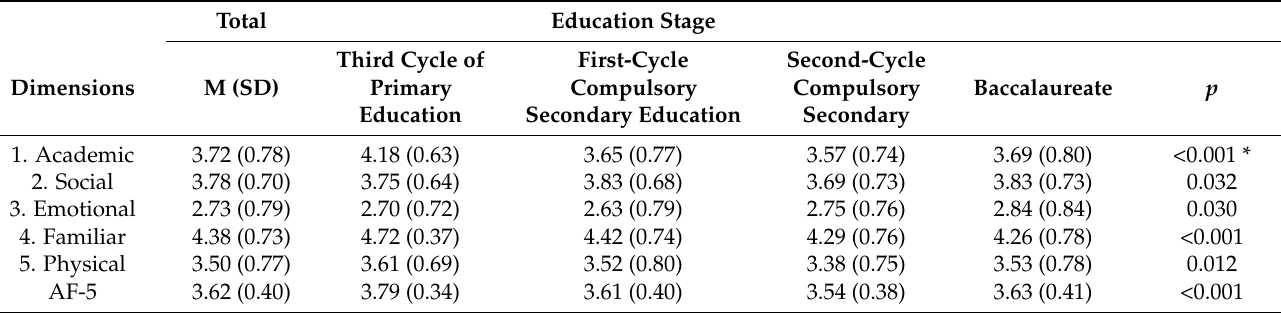
Table 2. AF-5 descriptive analysis and differences of each